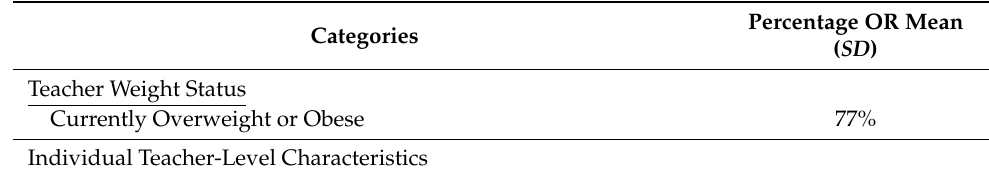
Table 2. Demographics and Well-being/Health of Surveyed ECE Teachers during the Early Pandemic (n = 1106). Categories